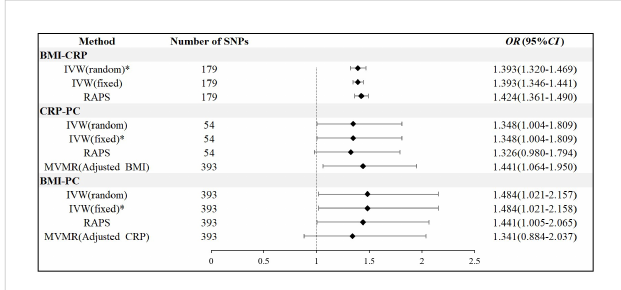
FIGURE 2 Two-sample and multivariable Mendelian randomization